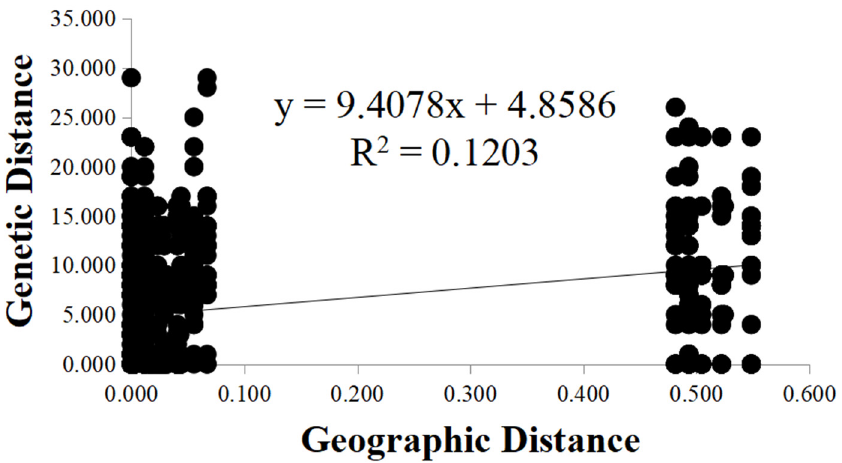
Figure 3. Mantel test between genetic distance and geographic distance among the A. exitialis pop- ulations.